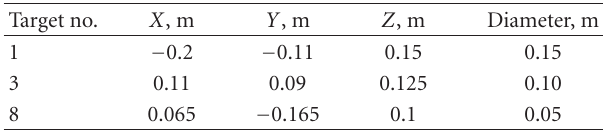
Table 2: Parameters of spherical targets used in point target simulations. based on the graphically estimated true target positions seen in Figure